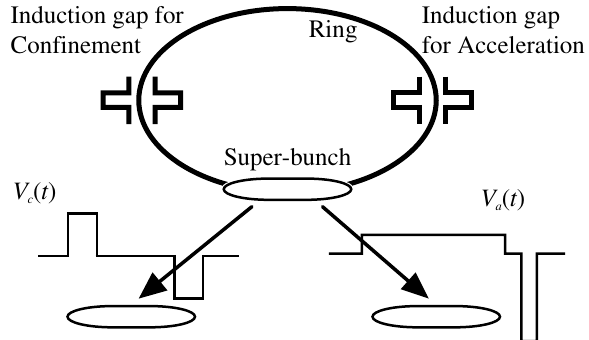
FIG. 1. Schematic view of the induction synchrotron. V the barrier voltage for the longitudinal confinement and V the accelerating